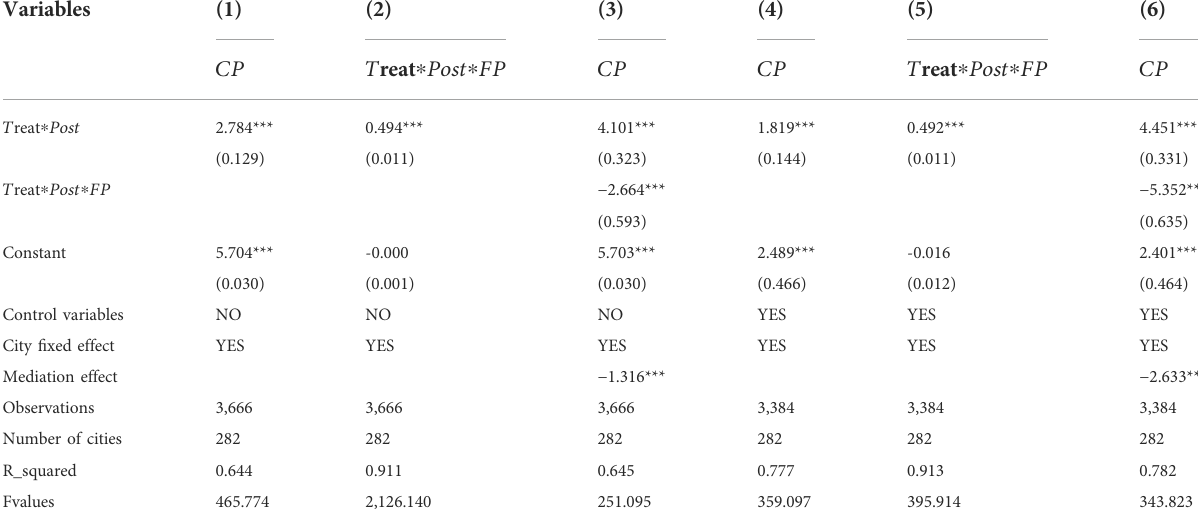
TABLE 12 Estimation results based on the fi scal pressure brought about by the low-carbon city pilot policy.